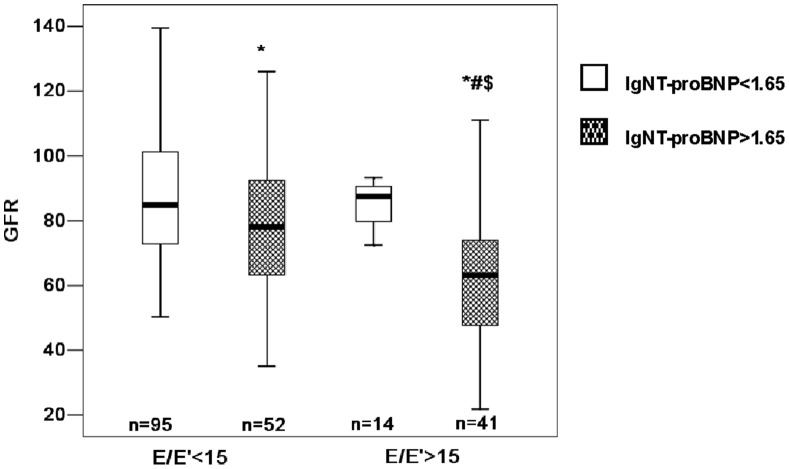
Association of E/E′ and NT-proBNP with GFR.(white box, lgNT-proBNP<1.65; shaded box, lgNT-proBNP>1.65) * P<0.01 vs lgNT-proBNP<1.65 and E/E′<15, # P<0.01 vs lgNT-proBNP>1.65 and E/E′<15, $ P<0.05 vs lgNT-proBNP<1.65 and E/E′>15.